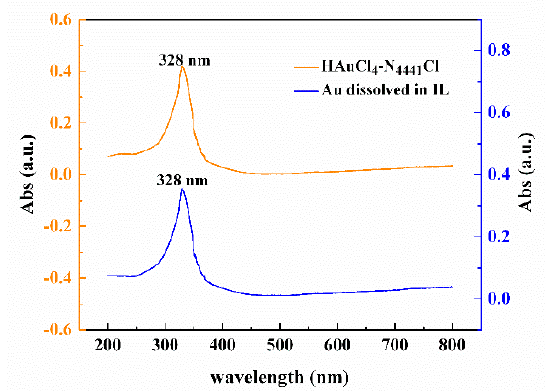
Figure 2. UV-Vis result of the ionic liquid system after dissolving gold and the mixture of N 4441 Cl and HAuCl 4 .